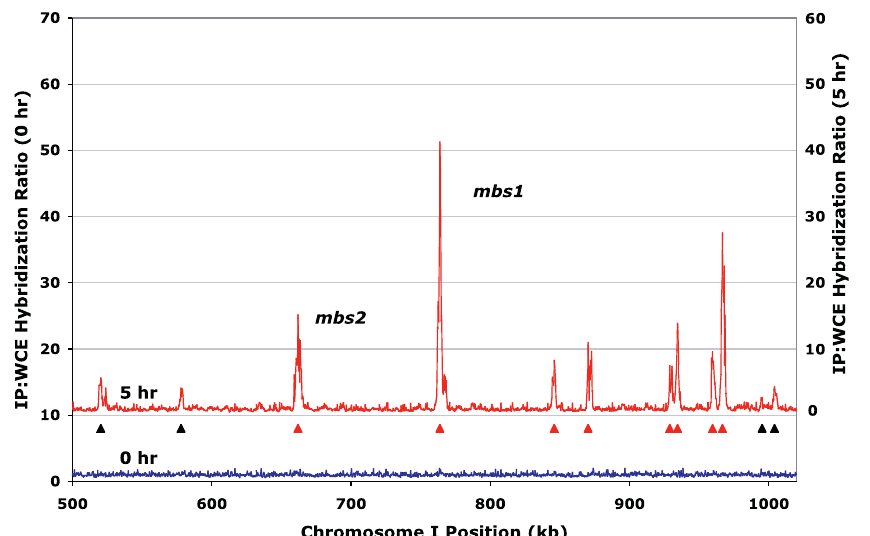
Figure 1. Rec12-DNA Linkages Occur at Strong Hotspots Separated by Cold Regions across Not I Fragment J (524-1025 kb from the Left End of Chromosome I) Haploid strain GP6013 bearing the rec12–201::6His-2FLAG allele was induced and analyzed for Rec12-DNA linkage by microarray analysis before (0 h; blue line) and 5 h (red line; mean of two experiments) after meiotic induction. Data are the median-normalized IP:WCE ratios for each oligonucleotide, spaced ; 300 bp apart [14]. Probes with ratios . 2 were replaced with values of 1 unless they occurred in contiguous groups of . 2 spots (see text for justification); high values within contiguous groups (hotspot peaks) in the 5-h data were omitted if they were also spuriously high in the 0-h data. See Figure S2 for alternative data presentations, Figure S5 for repeat experiments, and Figure S7 for the entire genome. Carets indicate weak (black) and prominent (red) Rec12 peaks identified by PeakFinder. Left and right vertical axes are offset to allow separation of the 0- and 5-h